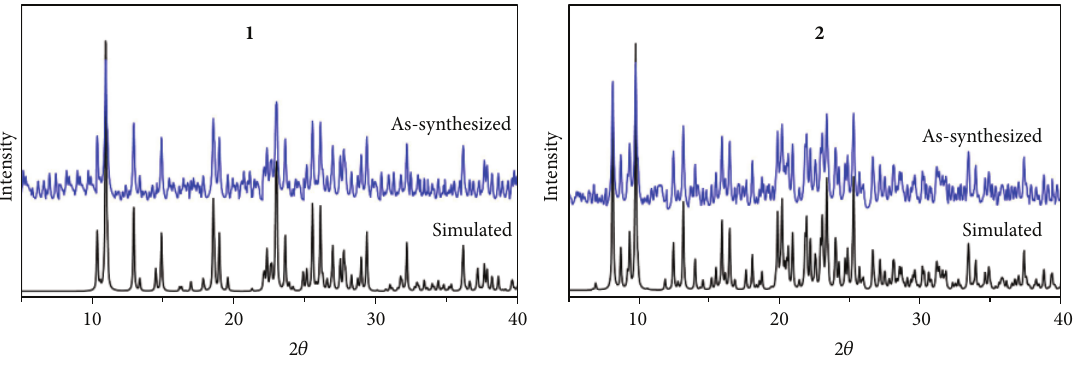
Figure 4: PXRD patterns in complexes 1 - 2 .